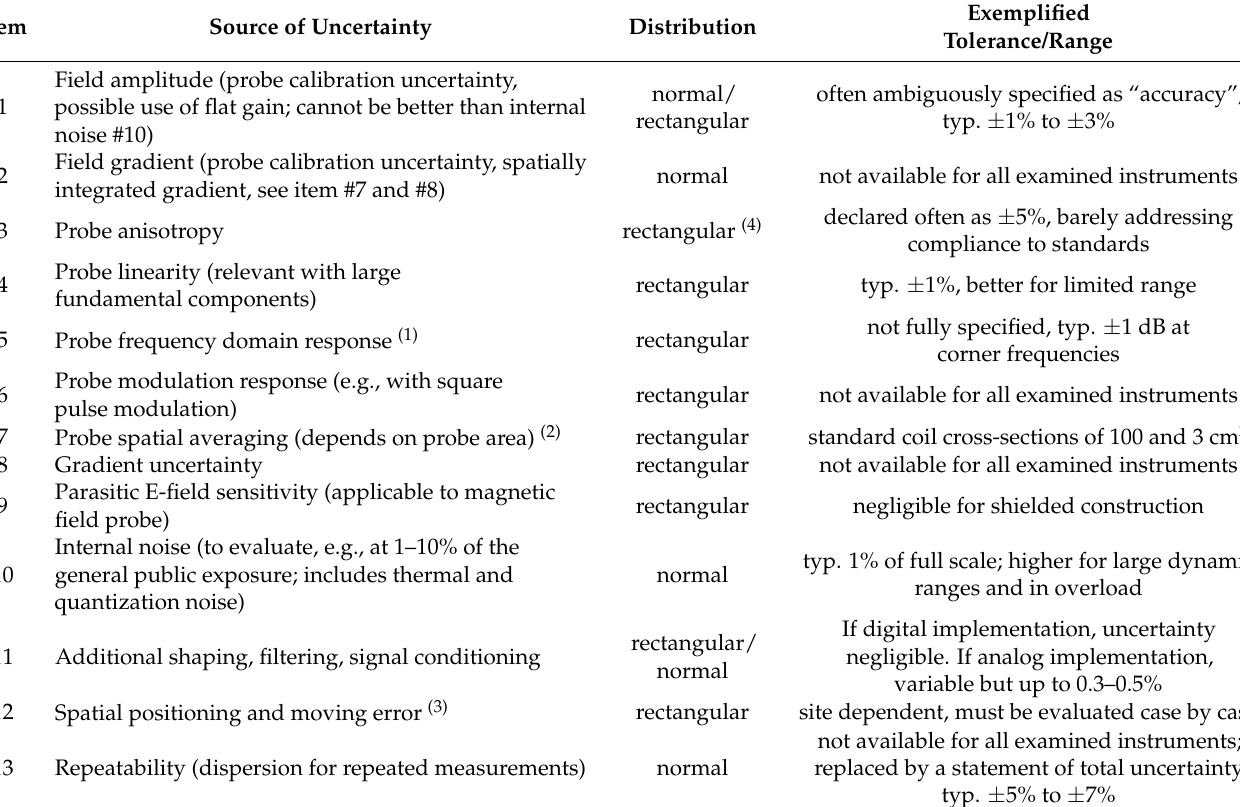
Table 7. Elements contributing to uncertainty and indications for uncertainty budget